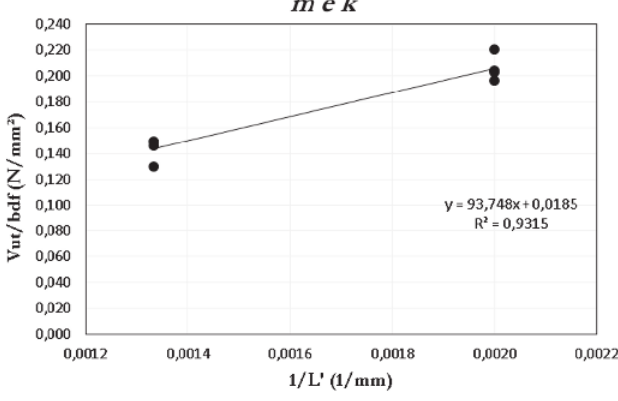
Regressão linear dos dados dos modelos